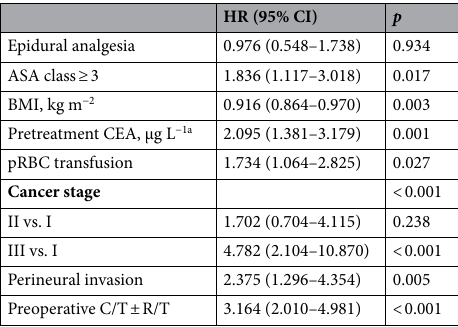
Table 4. Forward model selection for cancer-specific survival. HR hazard ratio, CI confidence interval, ASA American Society of Anesthesiologists, BMI body mass index, CEA carcinoembryonic antigen, C/T chemotherapy, pRBC packed red blood cells, R/T radiotherapy. a On base-10 logarithmic